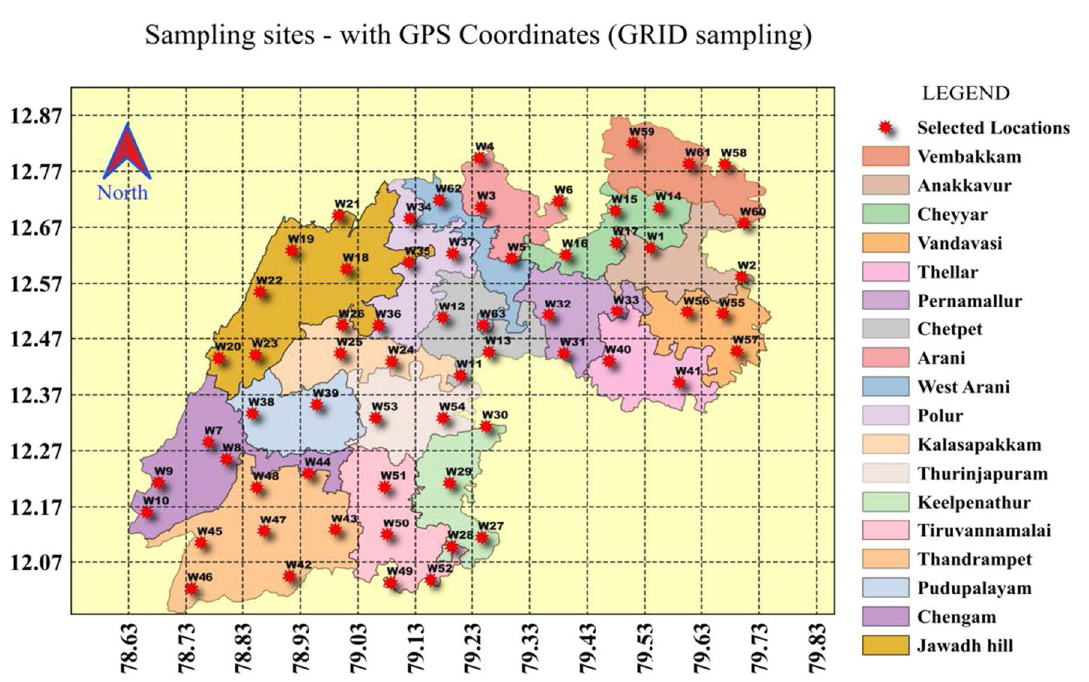
Fig. 2 Sampling sites with GPS coordinates within the